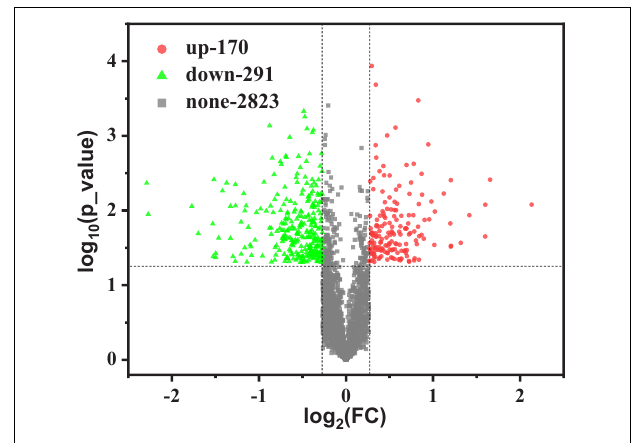
FIGURE 2 | Scatter plot of volcano differences. A volcano plot between the G40 and the G120–20 (+betaine) whose proteins are shown. The horizontal axis is the value of log 2 (FC). The vertical axis is the –log 10 ( p -value). The red dots represent up-regulated proteins (FC > 1.2), and the green dots represent down-regulated proteins (FC <